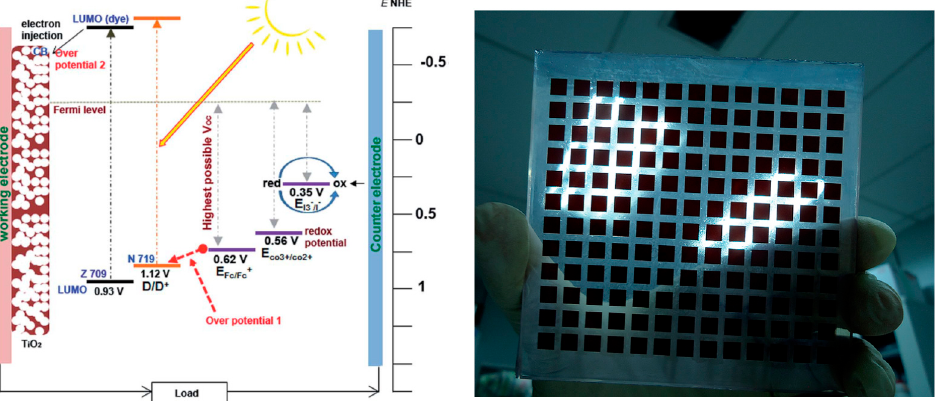
Figure 1. Schematic of the working mechanism of a DSC (Left); A photoelectrode (100 cm 2 ) for a DSSC module (Right). Reproduced from Ref. [45] with permission from The Royal Society of Chemistry.